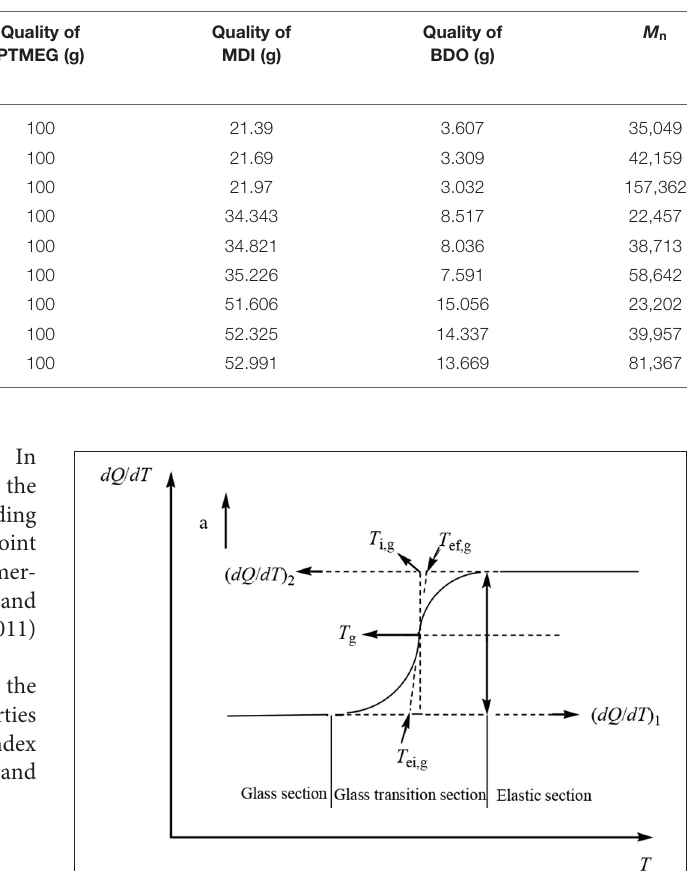
TABLE 7 | Composition and hard segment content of polyether-based TPU.